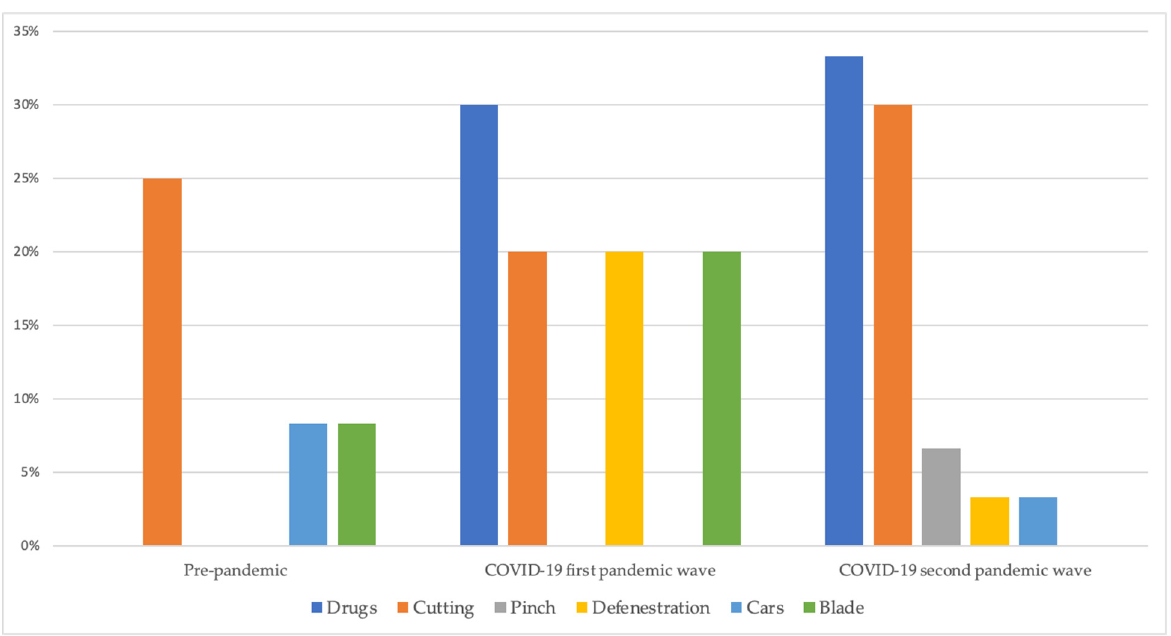
Figure 2. Proportion of injury modalities during the three examined